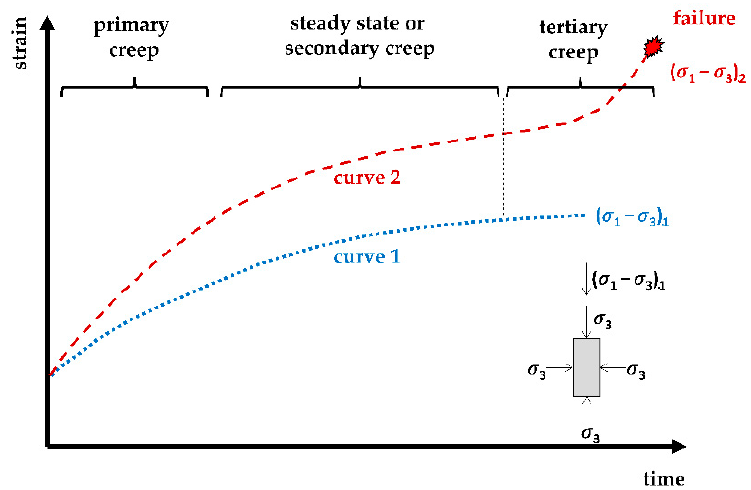
Figure 1. Different phases of creep in various stress regime, redrawn from [7].